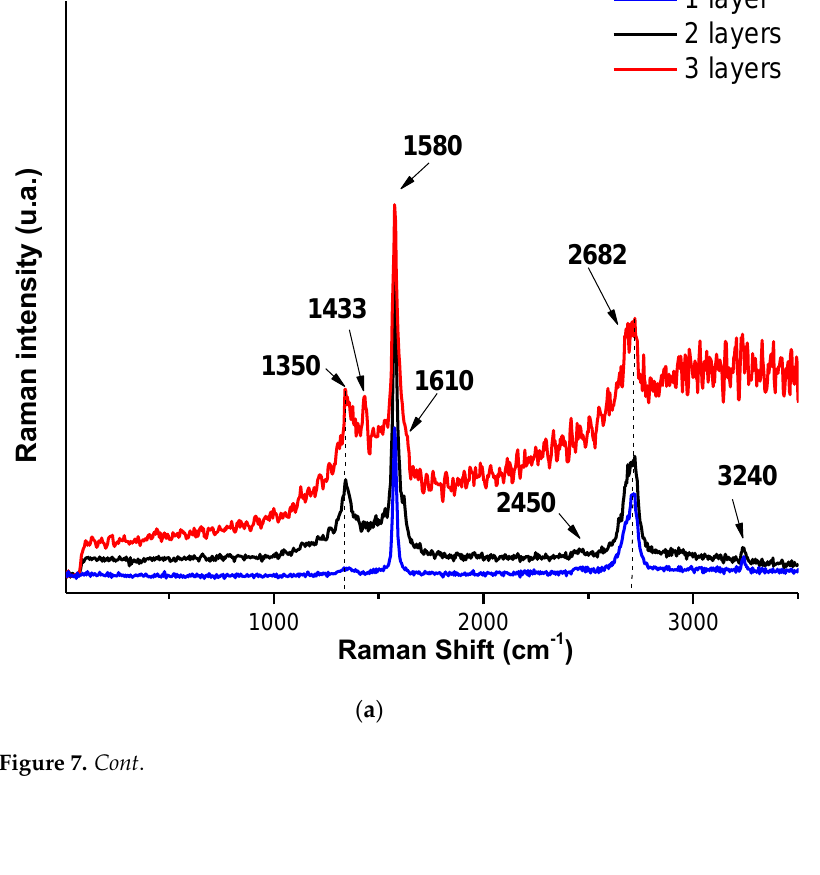
Figure 6. XRD profiles of ( a ) HCl, ( b ) HBr, and ( c ) PSS-doped PANI/graphene/PEDOT:PSS water- based formulation with one, two, and three layers (black, red, and blue, respectively).